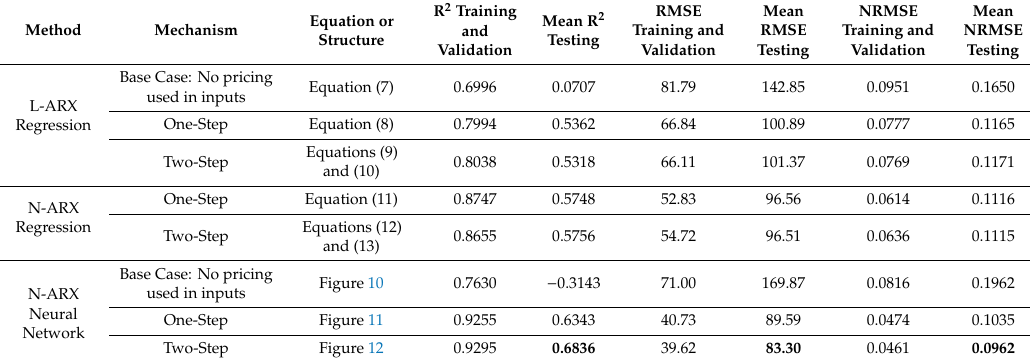
Table 2. Coe ffi cient of determination (R 2 ), root mean squared error (RMSE), and normalized root mean squared error (NRMSE) with the training and validation dataset vs. mean values with the ten testing